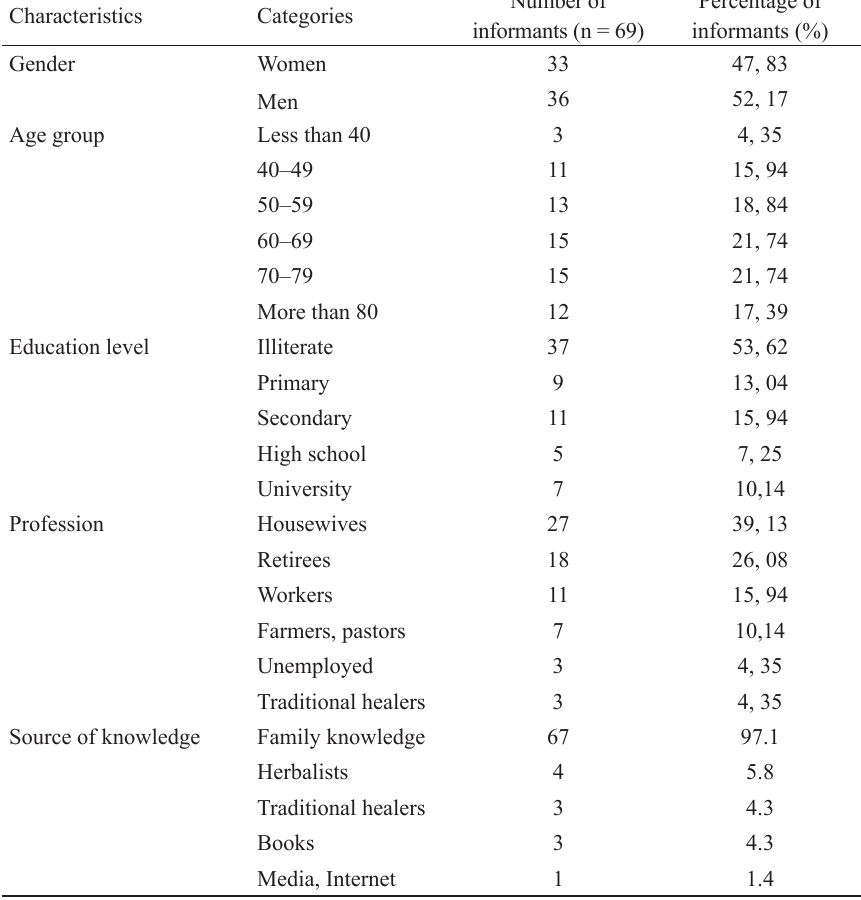
Table 2. Socio-demographic characteristics of the informants